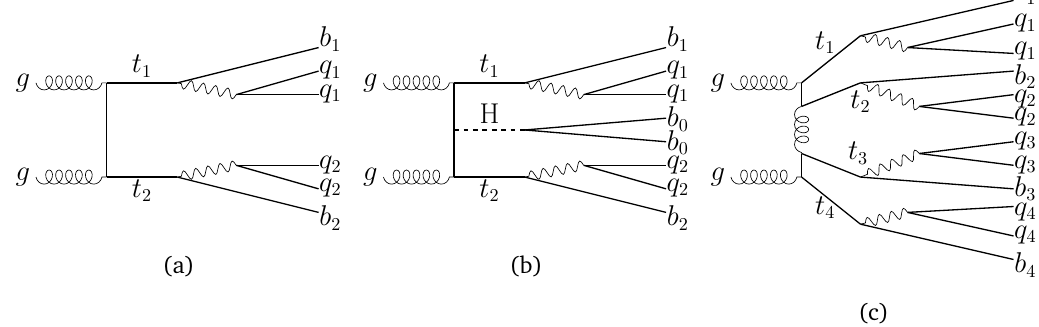
Figure 1: Feynman diagrams, a visual description of the decay of resonance particles into partons, for (a) t ¯ t events, (b) t ¯ tH events, and (c) t ¯ tt ¯ t